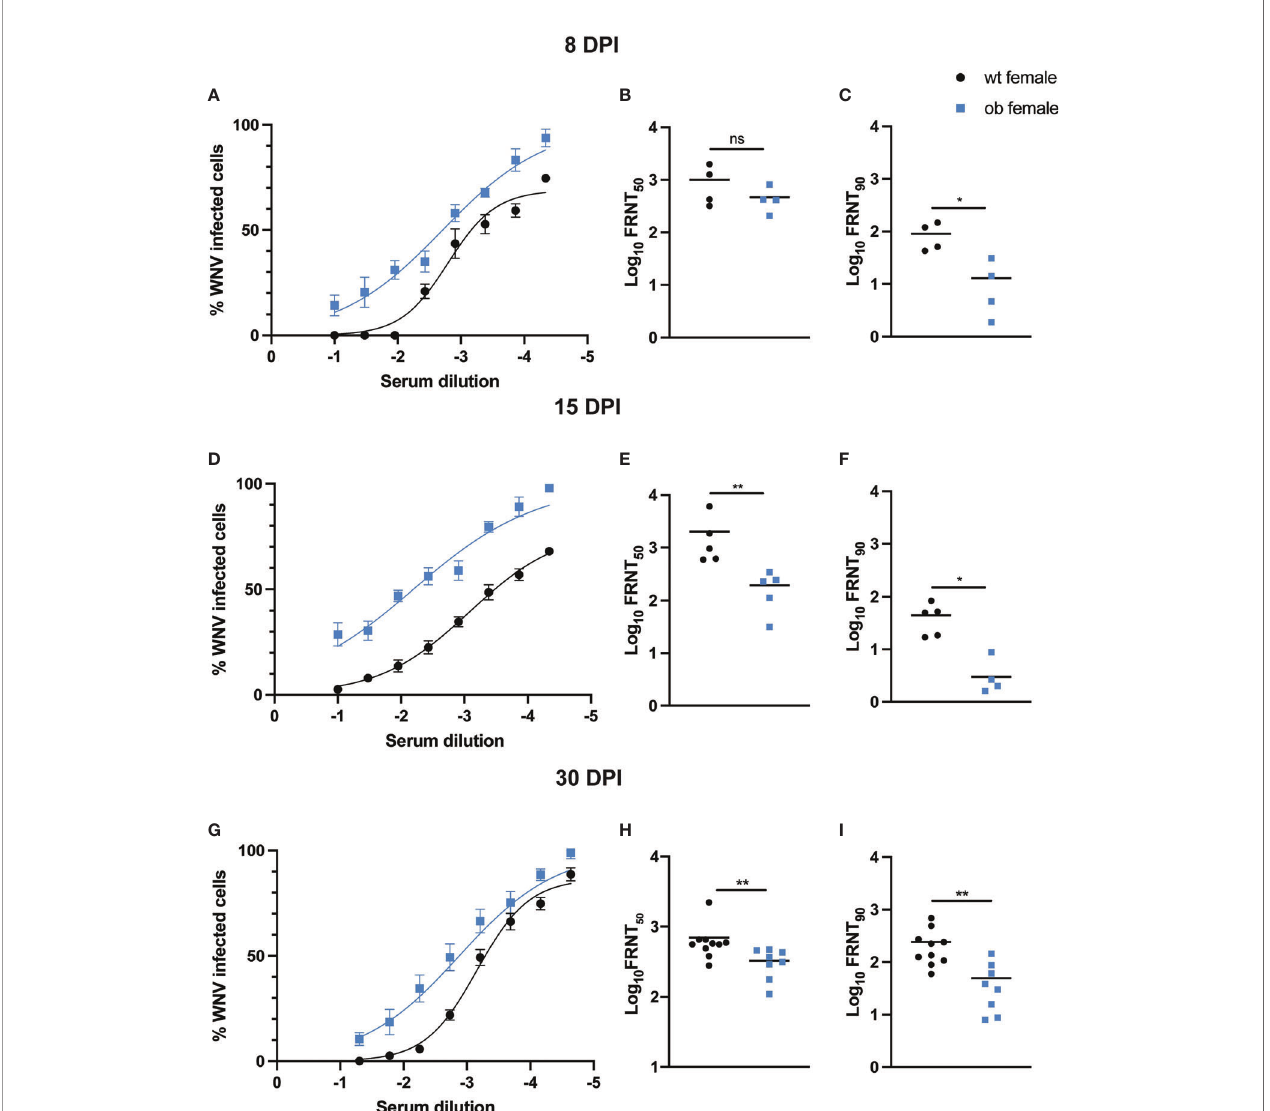
FIGURE 5 | Obese females have poorly neutralizing antibodies to WNV. At 8 (wt n = 4 and ob n = 4), 15 (wt n = 5 and ob n = 5) and 30 (wt n = 10 and ob n = 8) DPI, focus reduction neutralization tests were performed to assess neutralizing antibody function. Neutralization curves at each time point (A, D, G) show a higher frequency of infected cells when virus was incubated with serum derived from obese females. Although no differences are noted between FRNT50 values at 8 DPI between wild type and obese animals (B) , these values are signi fi cantly lower in obese females at 15 and 30 DPI when compared to wild type counterparts (E, H) , while FRNT90 values are signi fi cantly lower in obese females when compared to wild type at each time point tested (C, F, I) . Asterisks indicate statistically signi fi cant values (* p<0.05, ** p<0.001) as determined by Mann-Whitney test. ns, not signi fi